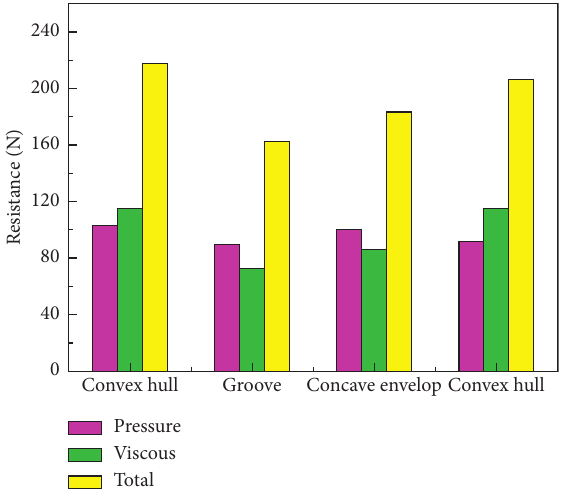
Figure 14: Drag distribution picture.